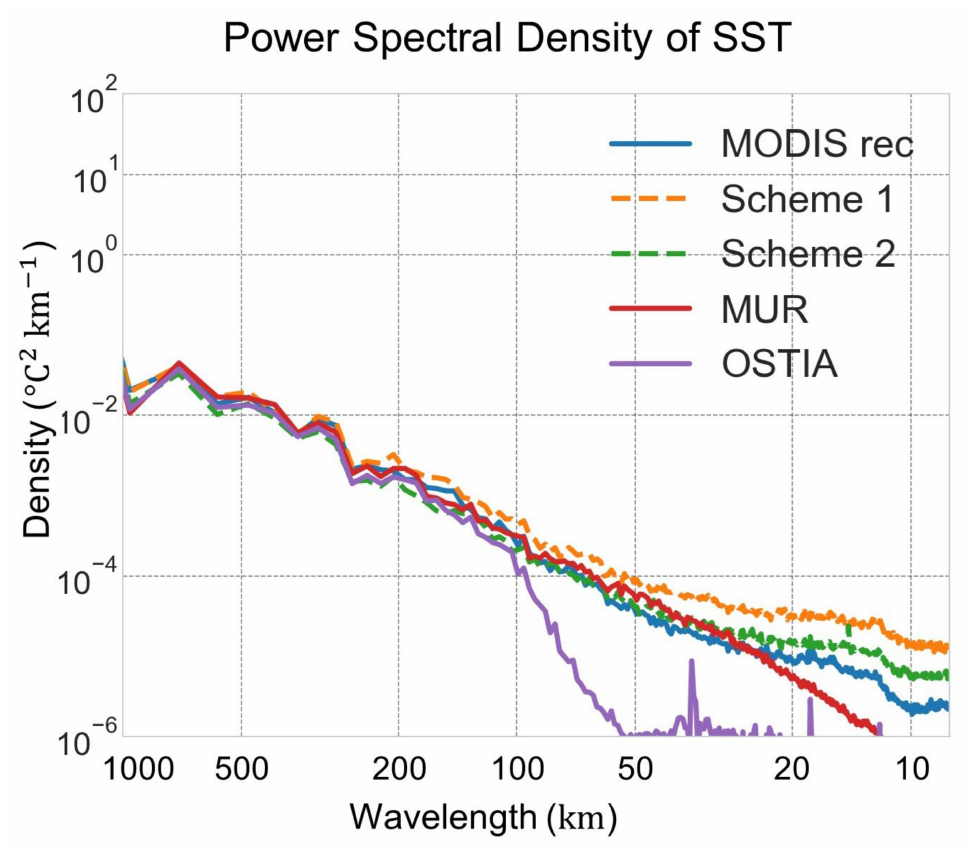
Figure 10. Power spectral density plots of the reconstructed MODIS SST, the scheme (Scheme 1/Scheme 2)-improved SSTs, and two operational SST products on 6 November 2018, which were calculated from the fast Fourier